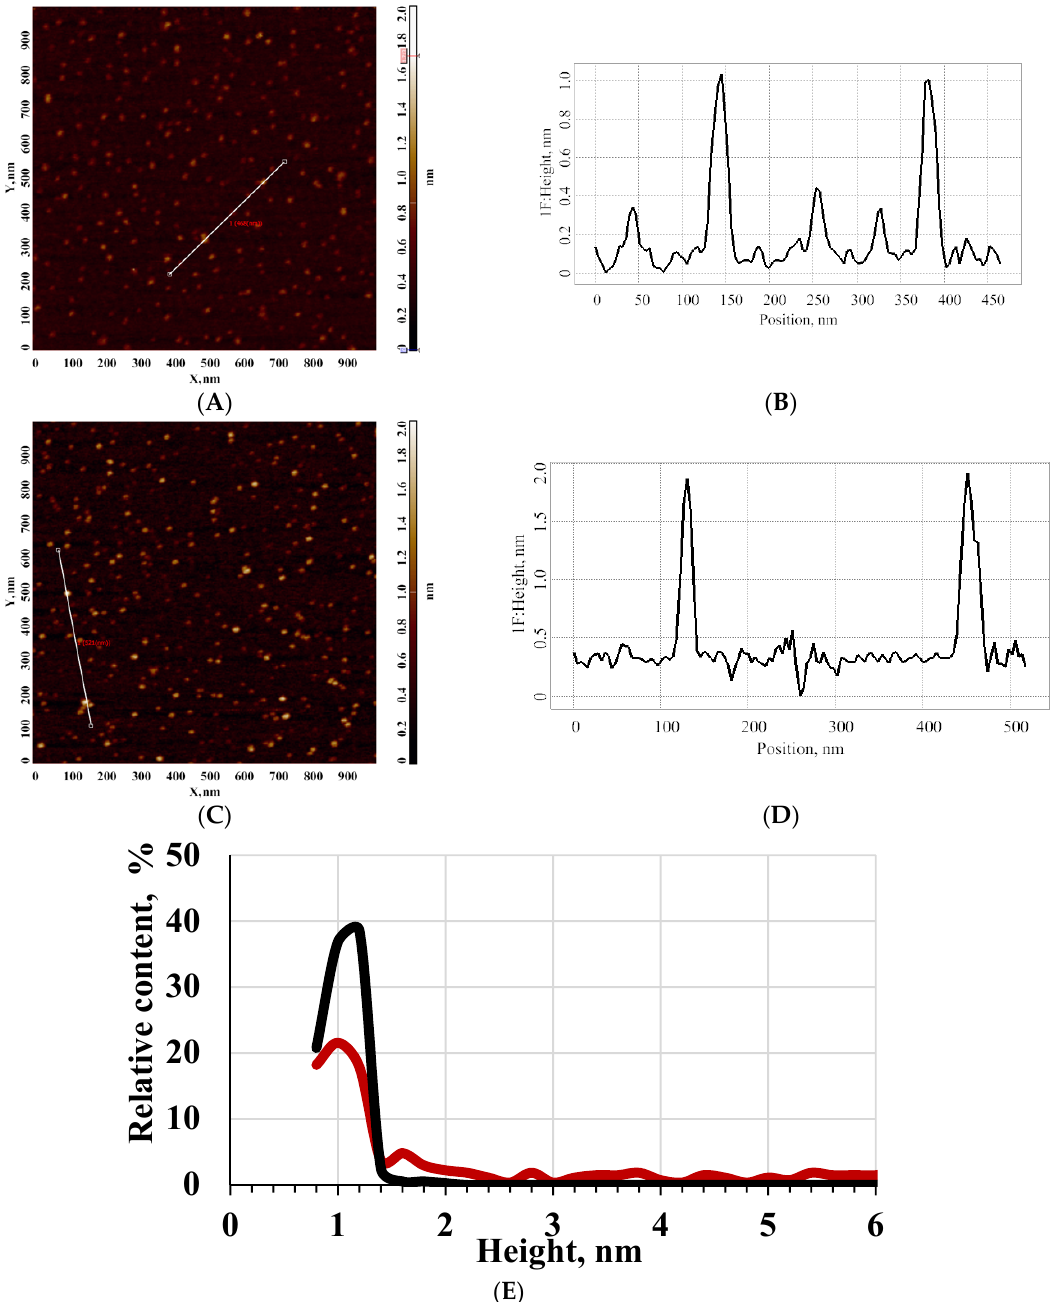
Figure 4. Results of AFM study of the effect of the shock wave impact on the HRP aggregation. Representative AFM images ( A , C ) and cross-section profiles ( B , D ) of the surface of mica substrate obtained after its incubation in 0.1 μ M aqueous HRP solution, which was either not subjected ( A , B ) or subjected ( C , D ) to the shock wave impact. The cross-section profiles correspond to the lines in the respective AFM images. ( E ) Distribution plots of the AFM-visualized objects with height ρ (h) , obtained for the solution subjected to the shock wave impact (red curve) and for the control HRP solution (black curve). Experimental conditions: the pressure behind the reflected shock wave was 10 atm for 4 ms, the rise-time of the shock wave front was about 80 nsec.